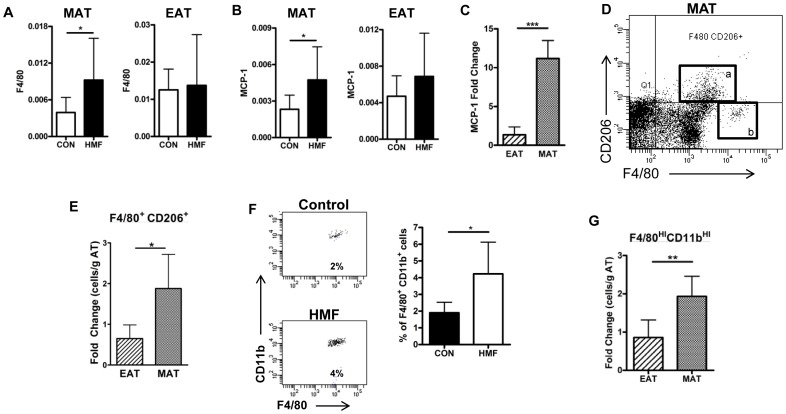
Diet-induced macrophage changes in MAT and EAT.(A) F4/80 expression (qPCR relative to GAPDH) in MAT and EAT (n = 4–8). (B) MCP-1 expression (qPCR relative to GAPDH) in MAT and EAT (n = 4–8). (C) Changes in MCP-1 protein detected by ELISA in extracts of adipose tissues and expressed as ratios of HMF diet over control diet adipose tissue levels in EAT and MAT. (n = 4–8) (D) Typical flow cytometry pattern of the SVF of the MAT showing (a) F4/80Int CD206+ and (b) F4/80HI CD206− macrophage populations. (E) Changes in the F4/80Int CD206+ macrophage population expressed as ratios of HMF diet over control diet adipose tissue cells/gm in EAT and MAT (n = 6). (F) Representative flow cytometry of the F4/80HI CD206− macrophage population in MAT showing CD11b expression with control and HMF diets; and graph of the percentage of these cells in the total macrophage population within the stromavascular fraction of MAT from control and HMF diets. (G) Changes in the F4/80HI CD206− CD11bHi macrophages expressed as ratios of cells/g in HMF diet over control diet EAT and MAT.